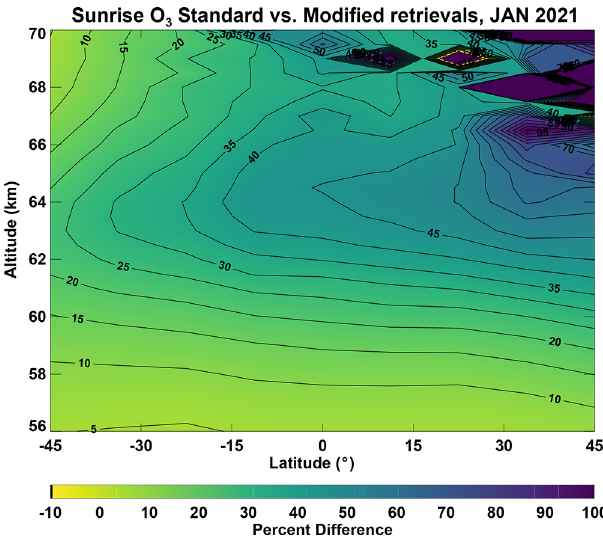
Figure 11. Latitudinal average of the percent difference in sunrise O 3 between the standard (archived) retrieval and a retrieval includ- ing diurnal variations along the LOS, as a function of latitude and altitude for January